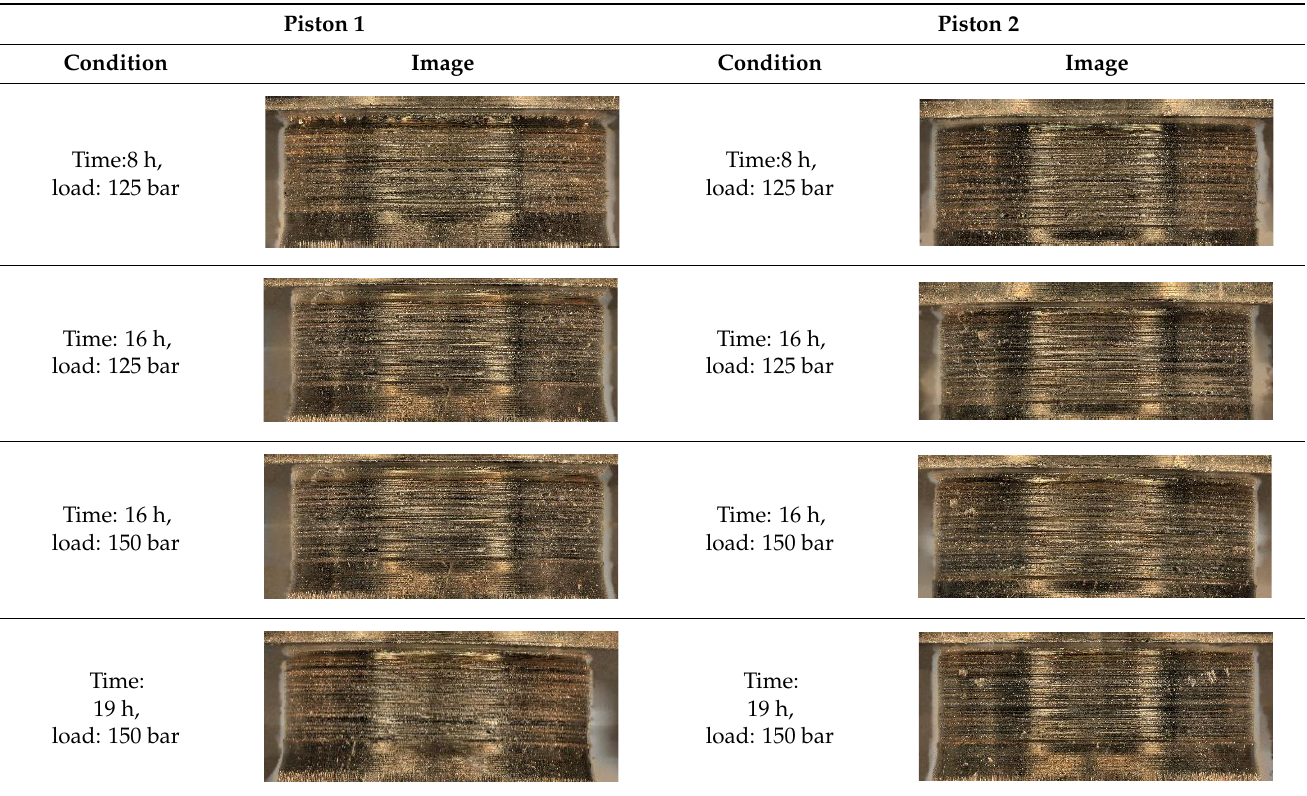
Table 7. Cont. Piston 1